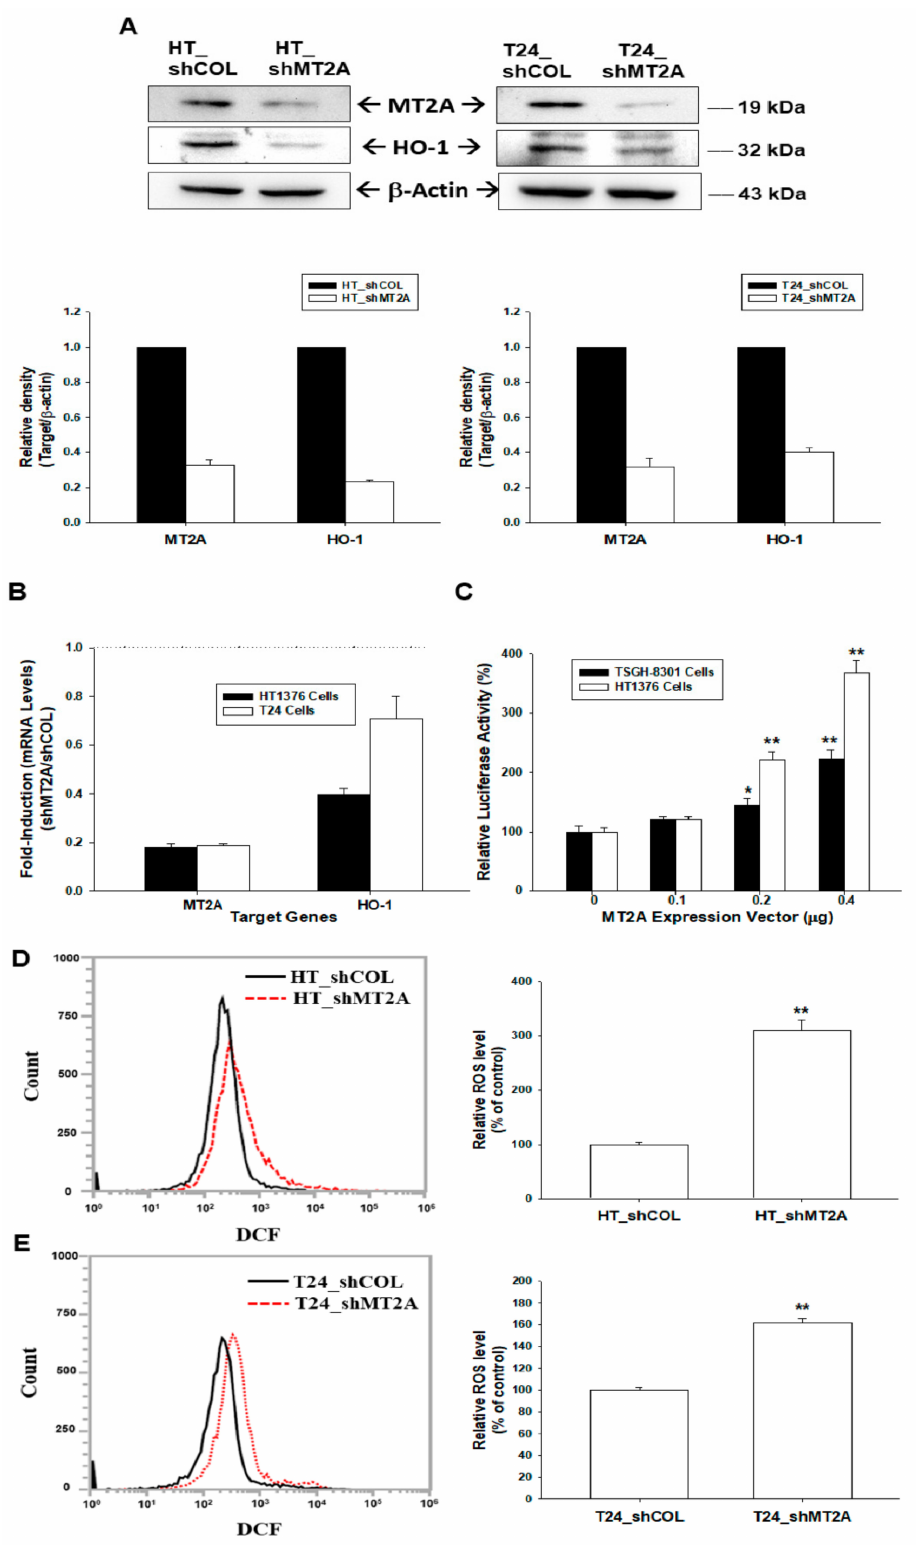
Figure 2. MT2A modulates the heme oxygenase-1 and endogenous reactive oxygen species in bladder carcinoma cells. ( A ) Protein levels of MT2A and HO-1 after knockdown of MT2A in HT1376 (left) and T24 (right) cells were examined by immunoblot assays. The quantitative data are presented as the intensity of the protein bands of the target proteins/ β -actin relative to the mock-knockdown